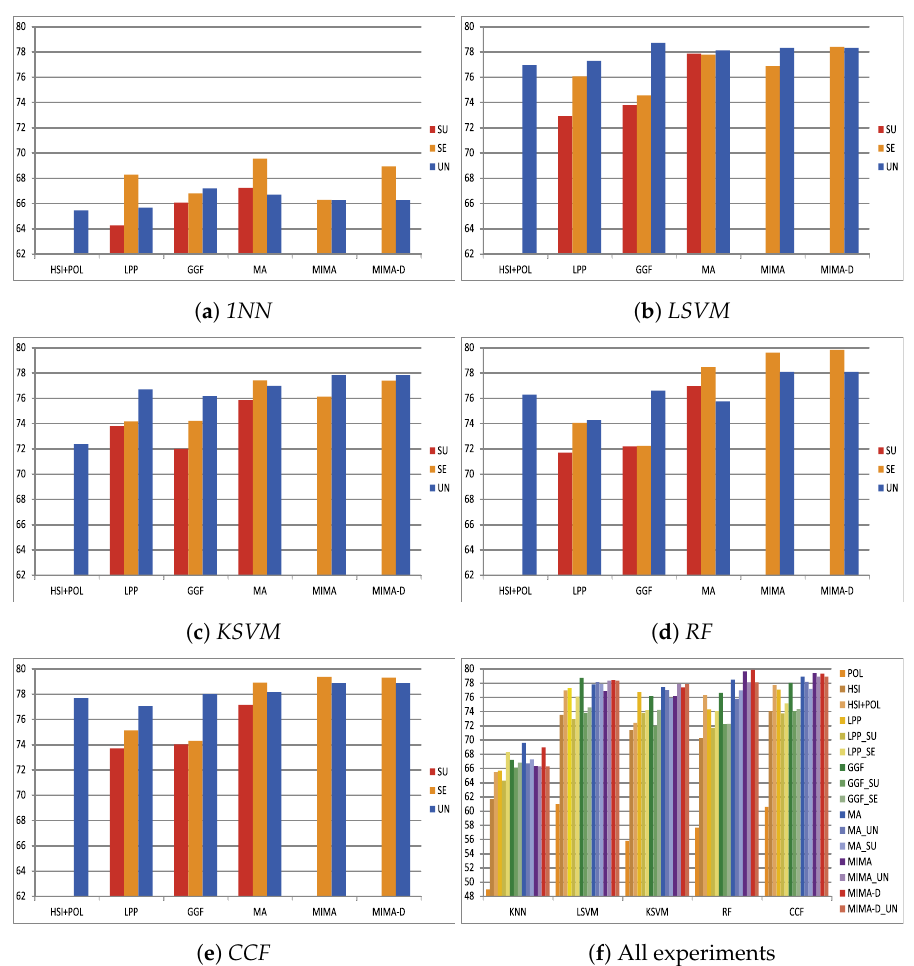
Figure 4. Comparison of the classification accuracies of different classifiers applied on the Berlin data set. Each chart is resulted from a corresponding classifier. The right bottom chart demonstrates all the overall accuracy resulted by applying five classifiers on every fused data achieved from the selected 16 algorithms. The y -axis report the overall accuracy in percentage (%). The ‘SU’, ‘SE’, and ‘UN’, represent supervised, semi-supervised, and unsupervised,